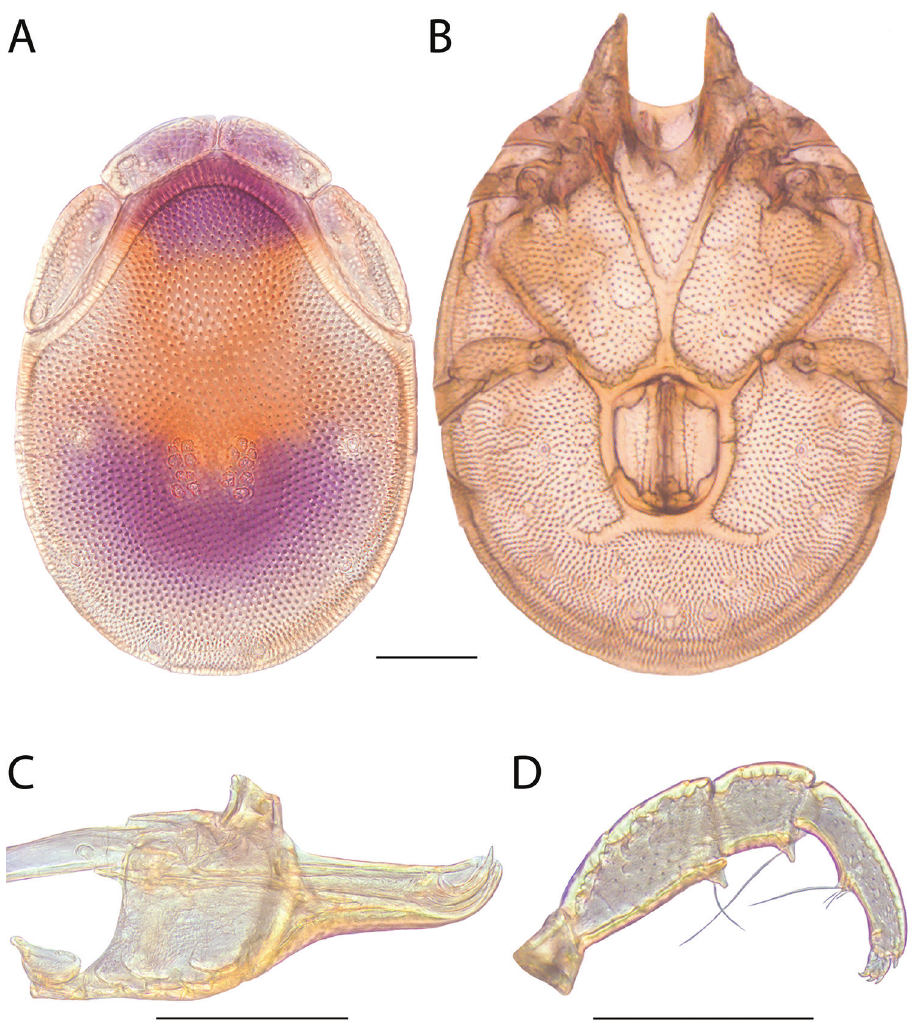
Figure 101. Torrenticola interiorensis sp. n. male: A dorsal plates B venter (legs removed) C subcapitulum D pedipalp (setae not accurately depicted). Scale = 100